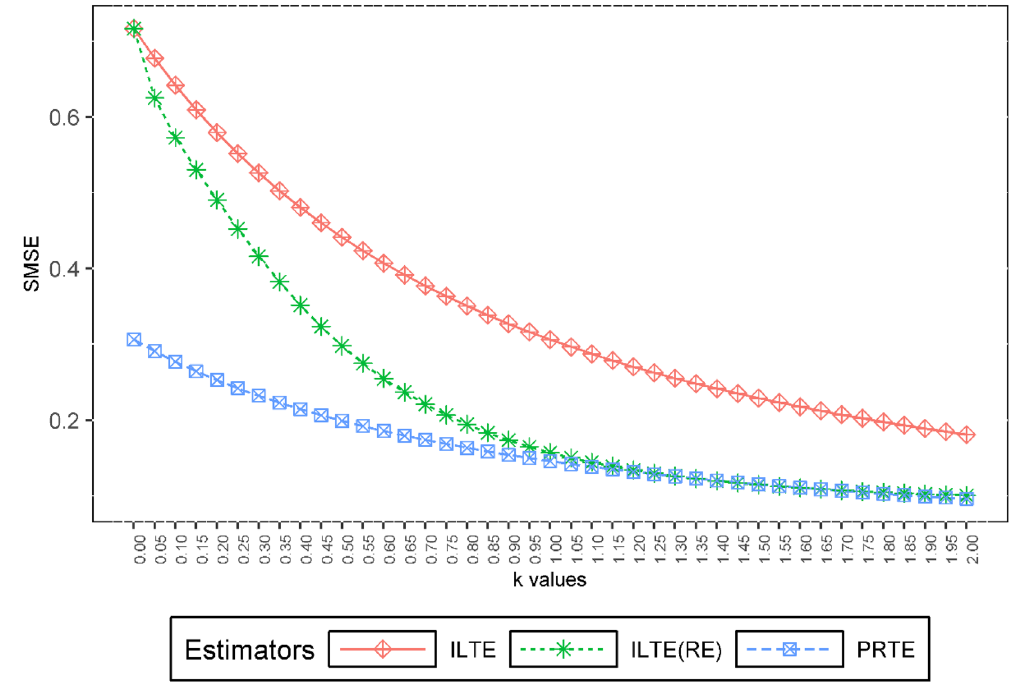
Figure 5. The SMSE values of ILTE, ILTE(PRE) and PRTE as a function of k